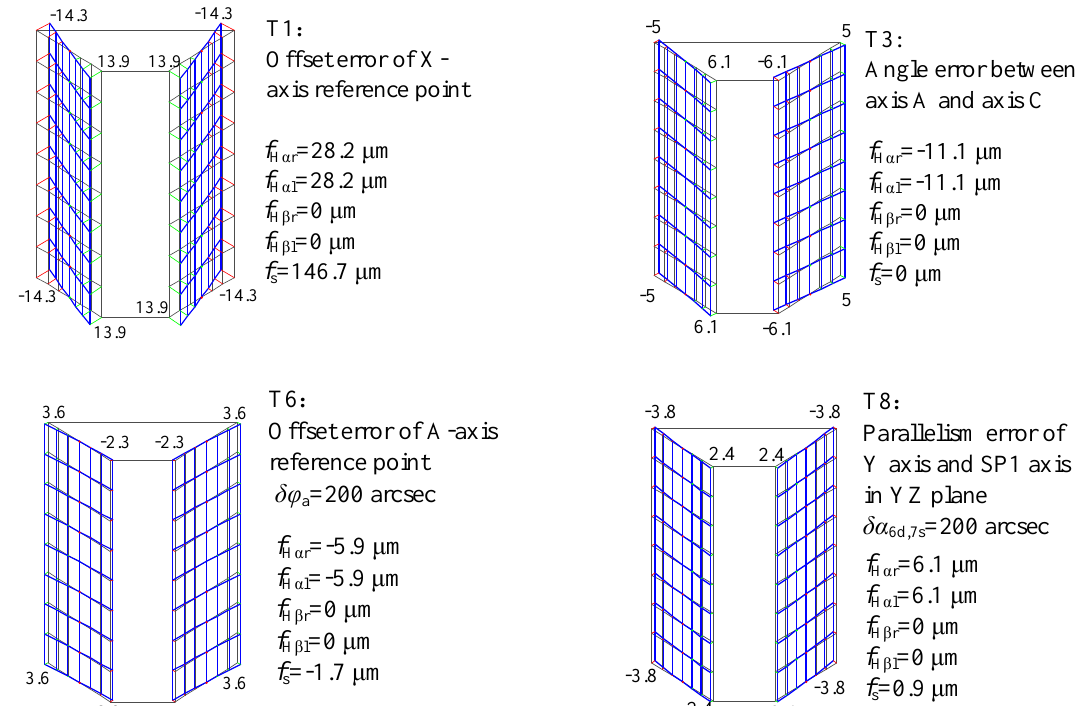
Figure 9. Deviations in tooth surface produced by assembly errors T2, T5, T11, T13, T14, and T15.